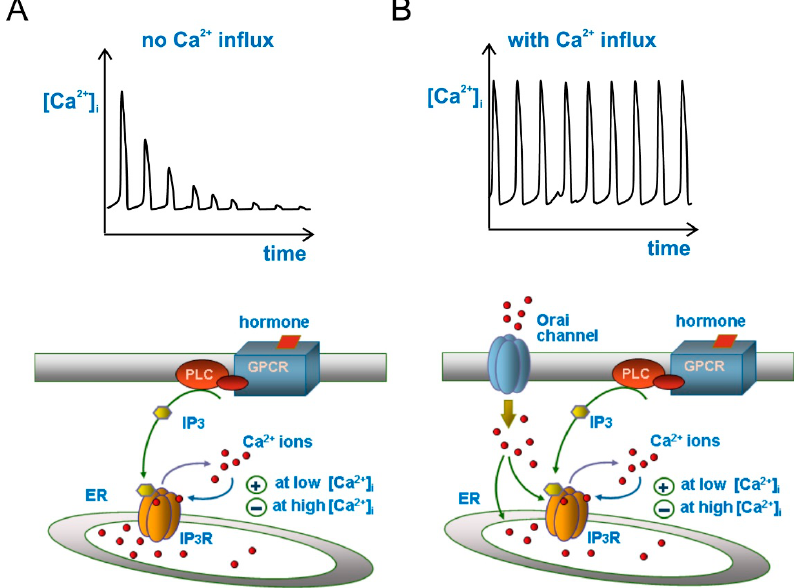
Figure 1. Ca 2+ oscillations in response to inositol thriphosphate (IP 3 ) increase, with and without Ca 2+ influx from extracellular space. ( A ) Bottom, drawing illustrating the hormone-based production of IP 3 that activates the IP 3 receptor to release Ca 2+ from endoplasmic reticulum (ER). The biphasic effects of cytosolic Ca 2+ on IP 3 receptor gating (the basic mechanism for Ca 2+ oscillations), whereby Ca 2+ modulates positively the receptor at low [Ca 2+ ] but negatively at high [Ca 2+ ], is also illustrated. Top, Ca 2+ oscillations as produced from the schematics below. Note the decaying trend of Ca 2+ spikes due to the absence of Ca 2+ influx from extracellular space; ( B ) Here the drawing has been enriched with a Ca 2+ influx apparatus from extracellular space through ER-depletion activated Orai channels on the plasma membrane ( bottom ) , which generates sustained Ca 2+ oscillations ( top ). For clarity, SERCA and PMCA Ca 2+ pumps have not been sketched in the drawing, although their activity has always been taken into account. For the same reason, we omitted to draw STIM protein of the ER.